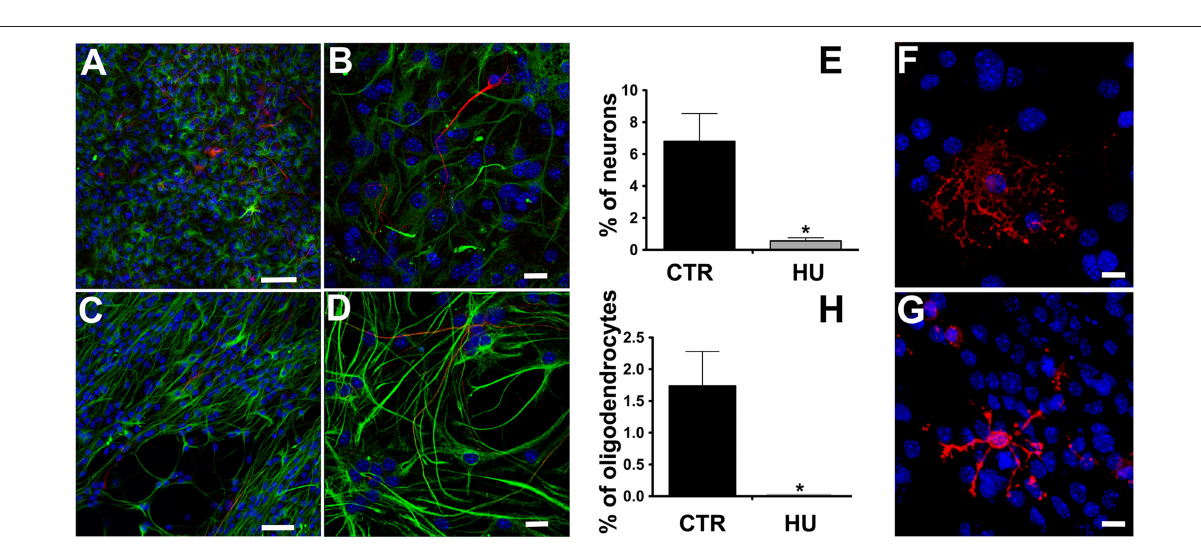
Frontiers in Neuroscience |